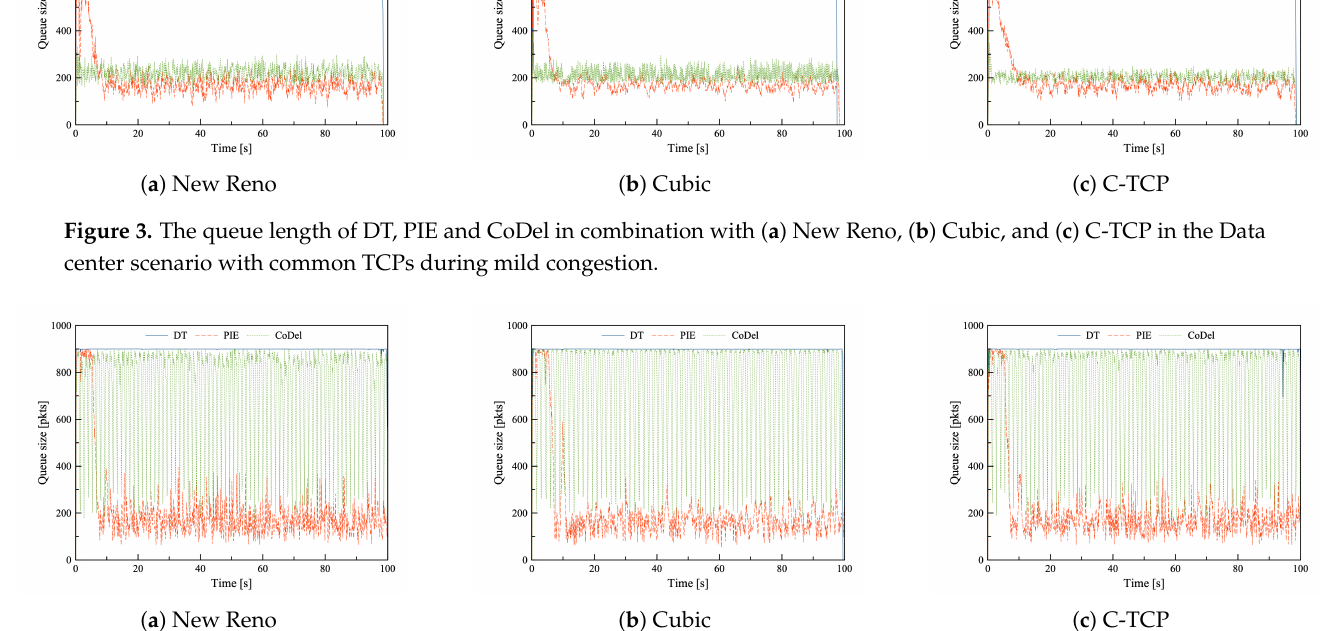
Figure 4. The queue length of DT, PIE and CoDel in combination with ( a ) New Reno, ( b ) Cubic, and ( c ) C-TCP in the Data center scenario with common TCPs during heavy